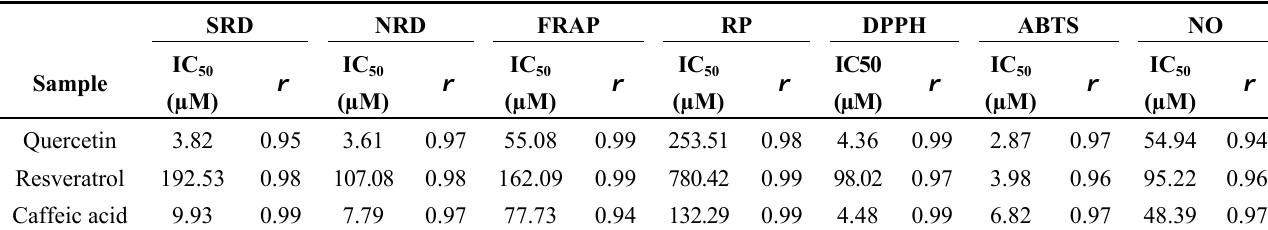
Table 1. Median inhibitory activities (IC polyphenols in different antioxidant